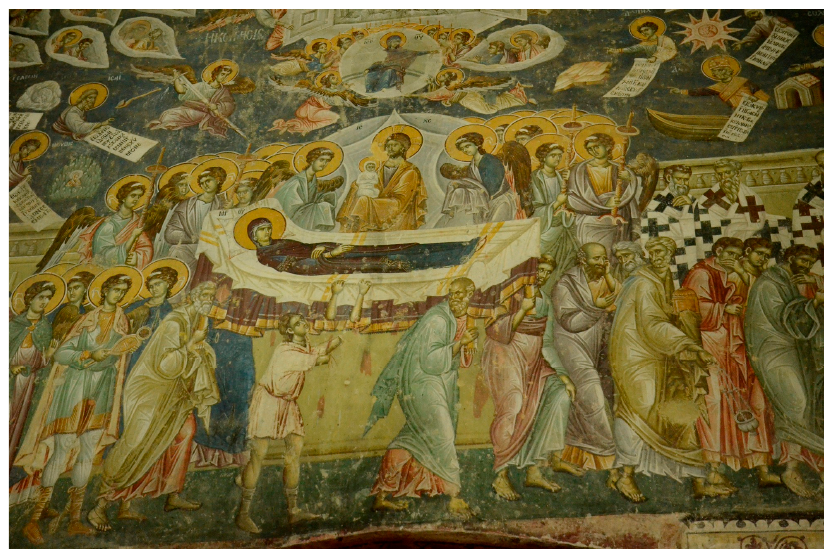
Figure 8. Dormition of the Theotokos , ca. 1317–1318, Church of St. George, Staro Nagori č ane, Republic of North Macedonia. (Photo credit: Tiffany Ziegler ).